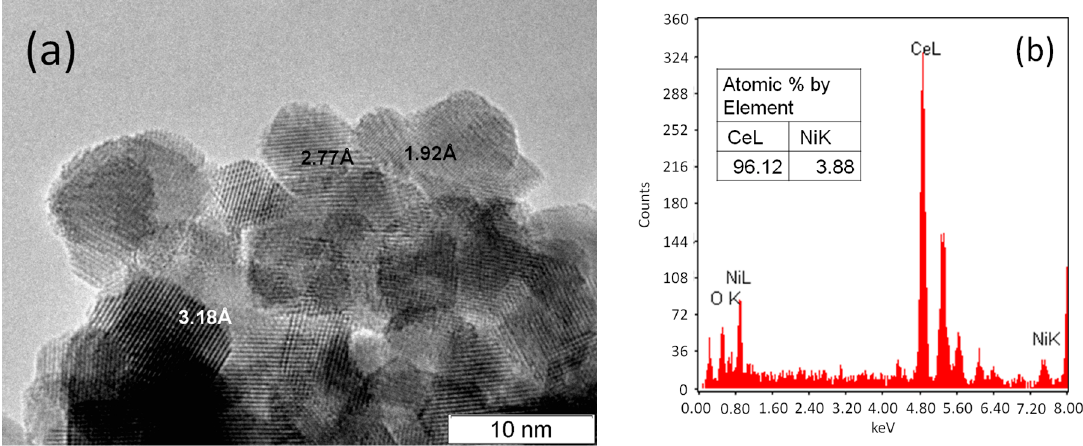
Figure 2. High ‐ resolution TEM image ( a ) and EDX spectrum ( b ) of as ‐ prepared 5% Ni/CeO 2 sample.